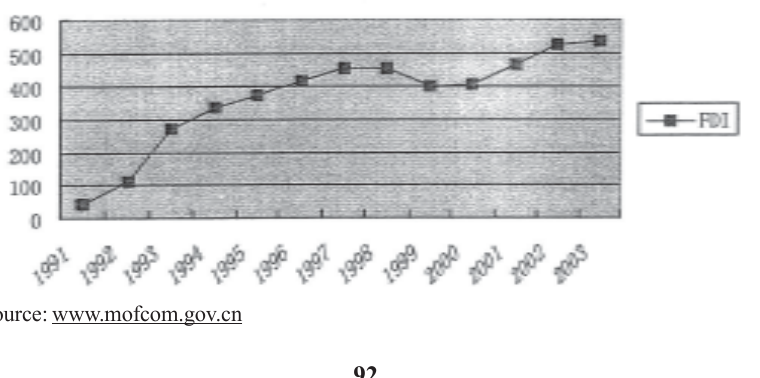
Figure 4 Annual FDI inflow to China (1991-2003)